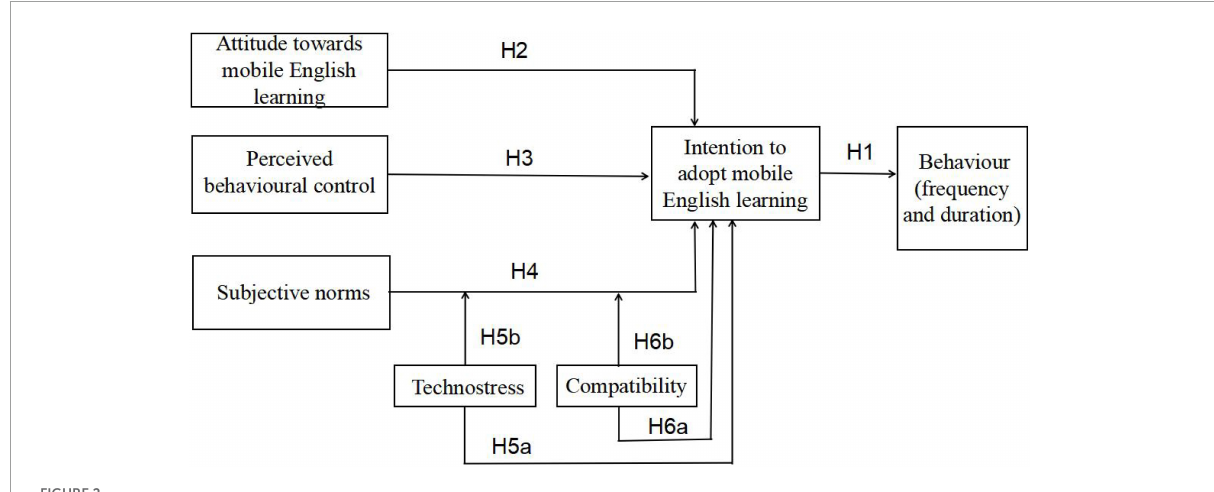
FIGURE2 The research